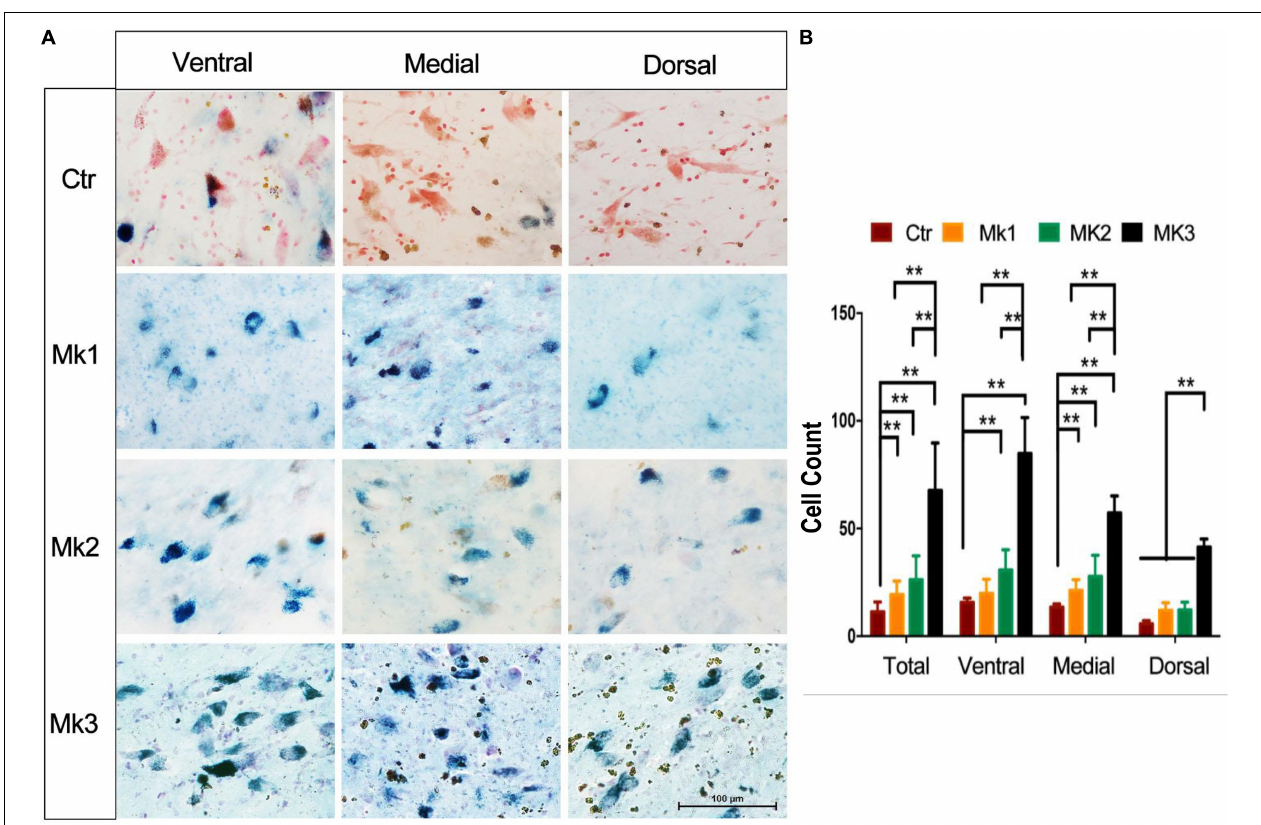
FIGURE 7 | Lipofuscin accumulation in the SN of MPTP-injected monkeys. (A) Lipofuscin was accumulated in neurons of the SN in MPTP-injected monkeys. The green or blue staining (Schmorl staining) denote lipofuscin accumulation in neurons, while red indicates control neurons (neutral red). Note that in control monkey, most of the neurons were stained with red, with little sign of green or blue staining. In contrast, MPTP-injected monkeys exhibited a significant amount of neurons with green or blue staining, indicative of lipofuscin accumulation. (B) The determination and comparison of the numbers of neurons that contain lipofuscin in control and in MPTP-injected monkeys. Cells that contain lipofuscin in the SN of control and MPTP-injected monkeys were counted and organized in overall (total) and in ventral, medial, and dorsal aspects of the SN. Note that lipofuscin accumulation in Mk3 was consistently the highest among all monkeys in all comparisons [ F (3,43) = 60.52, P < 0.0001]. In addition, lipofuscin accumulation in Mk1 [ F (3,53) = 10.54, P < 0.0001]and Mk2 [ F (3,56) = 16.12, P < 0.0001] was significantly higher than the control in overall comparison and that in medial aspect of the SN [Mk1, F (3,20) = 9.408, P = 0.0004; Mk2, F (3,18) = 7.587, P = 0.0017]. Mk2 lipofuscin accumulation was also higher than control in the ventral region [ F (3,17) = 6.108, P = 0.0052]. ANOVA, ∗∗ P < 0.01, ∗ P <